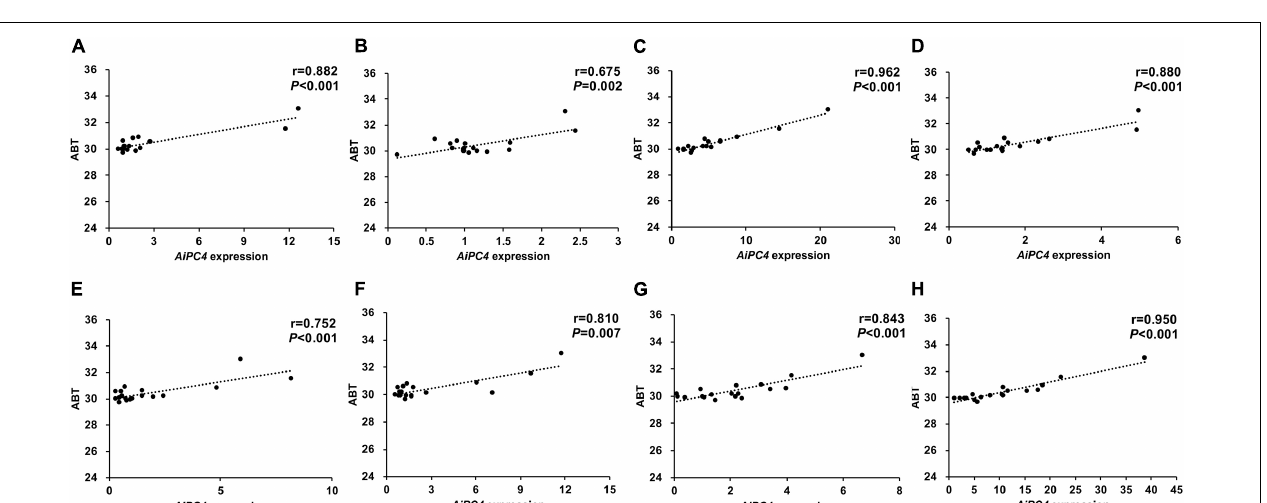
FIGURE 5 | Relative expression levels of AiPC4 in tissues of bay scallop. Three replicates were performed for each adult tissue and three technical replicates were conducted for each PCR. The comparison of the expression levels of AiPC4 among different tissues as performed using one way ANOVA followed by with a post hoc test. Bars with different superscripts indicate significant differences ( P < 0.05).